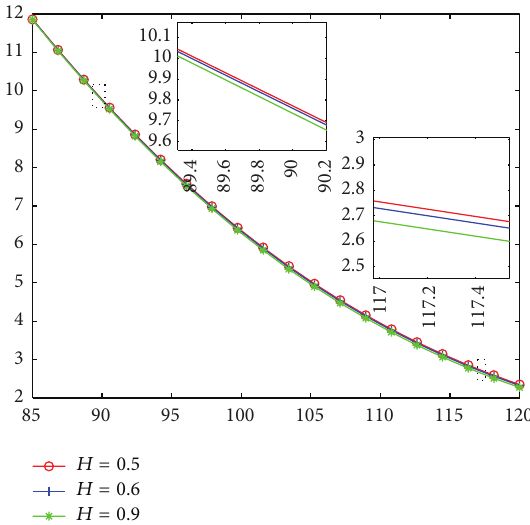
Figure 1: The influence of 𝐻𝑢𝑟𝑠𝑡 parameter 𝐻 .